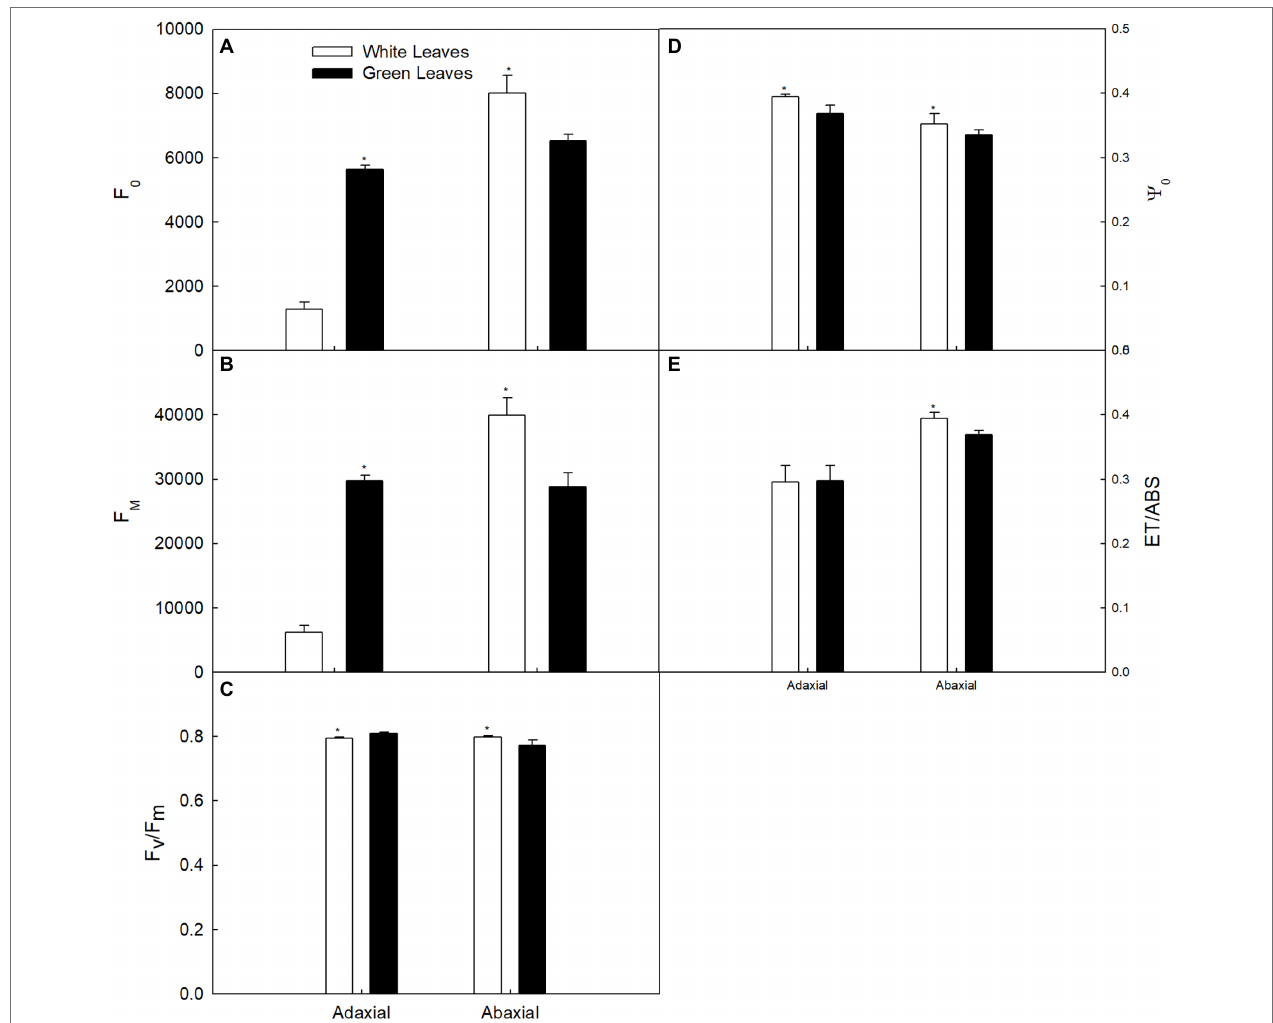
FIGURE 5 | Changes in the chlorophyll fluorescence parameter in white and green leaves. (A) F 0 . (B) F m . (C) The maximum quantum yield of photosystem II ( F v / F m ). (D) F 0 . (E) F 0